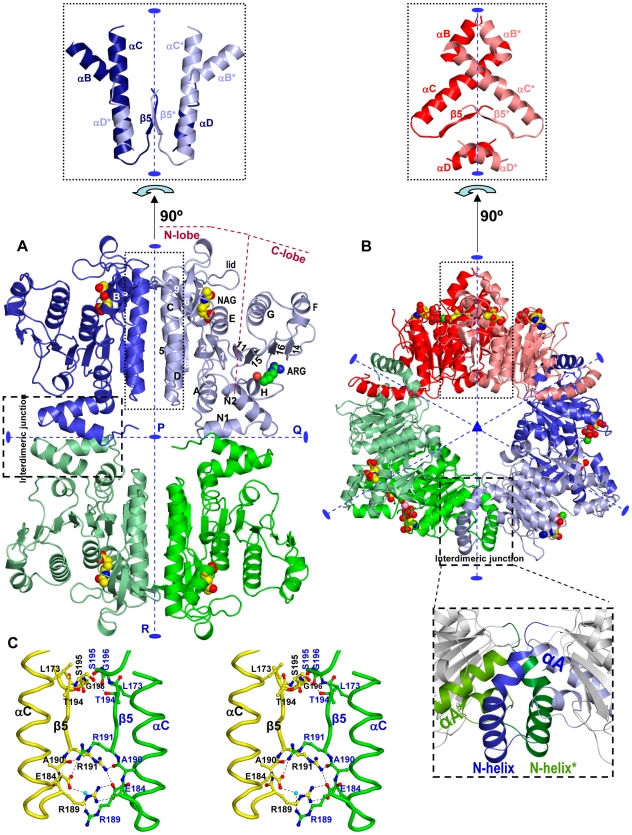
Structure of yNAGK lacking its DUF619 domain.Cartoon representation of (A) the tetramer of truncated yNAGK, as observed in the crystal soaked with arginine (2.1 Å resolution); and (B), of the hexamer of P. aeruginosa NAGK (PDB file 2BUF [7]). Two different hues of blue, green or red were used to identify the two subunits forming each R dimer. NAG and arginine in (A), and NAG and ADP-Mg in (B) are shown in space-filling representation. In (A) the N- and C-lobes and the secondary structure elements are labeled (helices with letters, strands with numbers) in the arginine-containing subunit, except helix B, which is labeled in the left-hand adjacent subunit. The 2-fold axes (labeled in (A) as P, Q and R) are shown as broken blue lines ending in blue ellipses, and the 3-fold axis of hexameric NAGK (B) is shown as a blue triangle. Interdimeric junctions are labeled and enclosed in broken-line rectangles in both (A) and (B). One such junction for the hexameric enzyme is enlarged in the lower inset of (B). In turn, the intersubunit junctions in the R dimer are enclosed in dotted-line rectangles, and they are illustrated in the top insets for (A) and (B), after 90° rotation around the R axes, relative to the main figures 3A and 3B. In the insets, elements from the two subunits are differentiated by the color code and also by placing asterisks on the labeled elements of one subunit. (C) Stereo view of the intersubunit bonds in the R dimer involving the β5 strands and the C-terminal moiety of helix C. This figure illustrates the β-sheet continuity across the intersubunit interface through side-chain bonds. Elements from one subunit are yellow and those from the other are green.